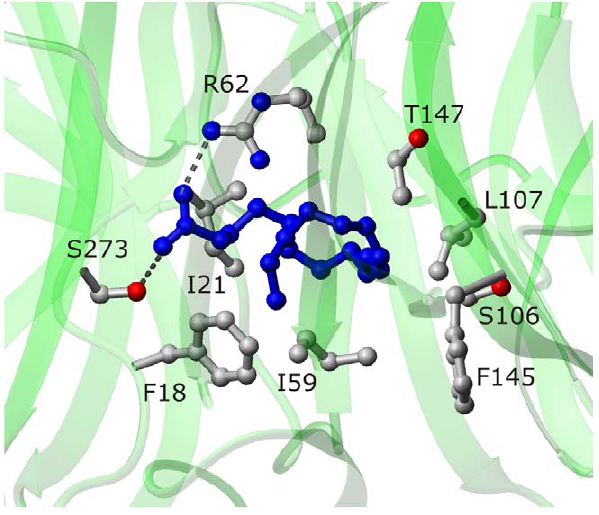
Figure 6. Suggested binding site on APEH Ss .by docking analysis for the t 10 c 12 -CLA (blue; ball-and-stick mode) isomer. The relevant APEH Ss residues are shown in ball-and-stick representation.